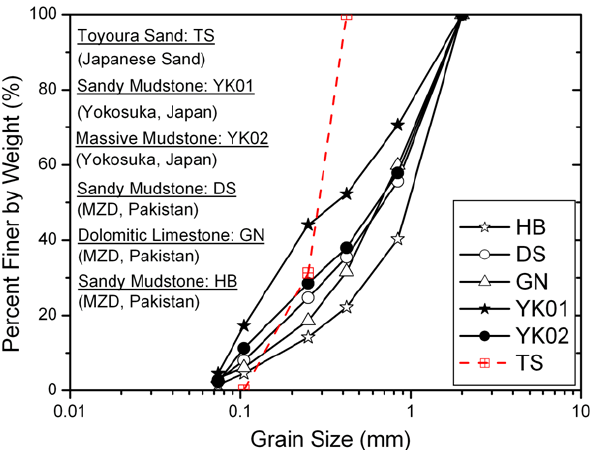
Fig. 3. Initial grain size distribution of all crushed rocks and Toy- oura sand. Figure 3. Initial grain size distribution of all crushed rocks and Toyoura sand. 3